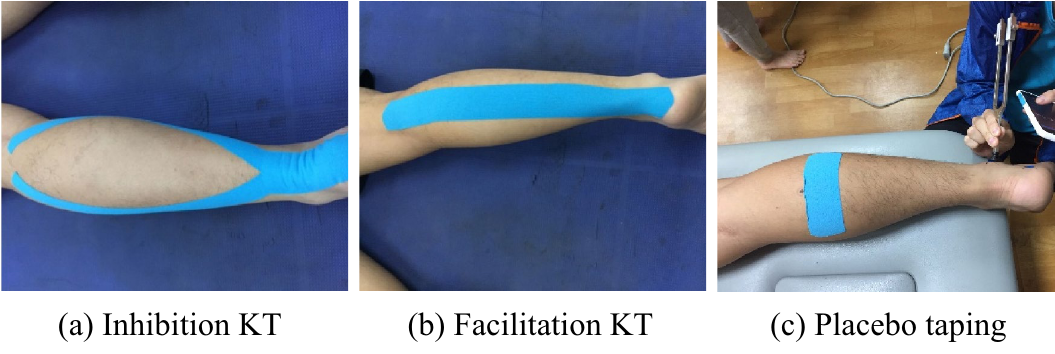
Figure 1. Applied direction of Kinesio taping ( a ) inhibition KT, ( b ) facilitation KT, ( c ) placebo